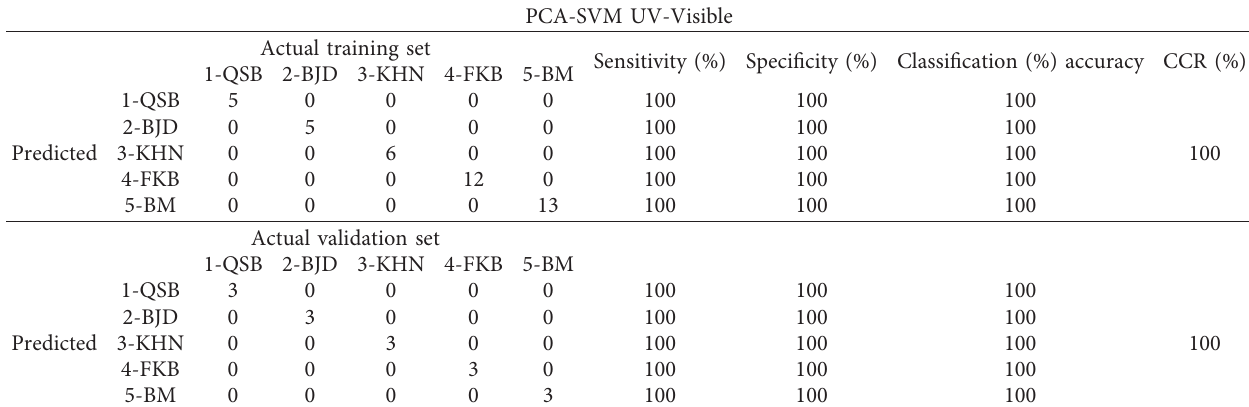
Table 4: Confusion matrix of PCA-SVM results on the first two principal components of UV-Visible spectral data.